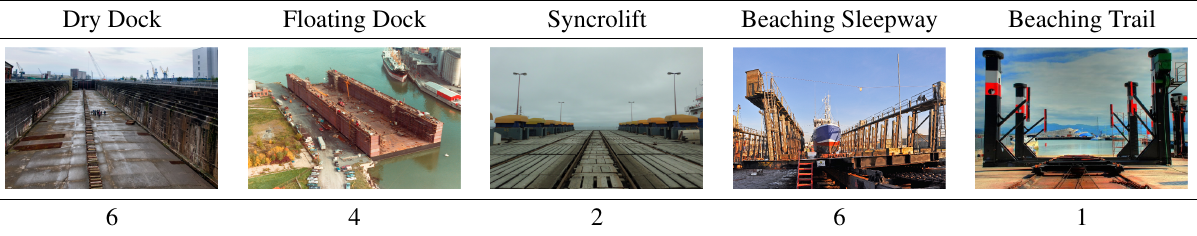
Figure 1. Typology of the Spanish shiprepair yards: Number of Shipyards working in every Beaching Method.